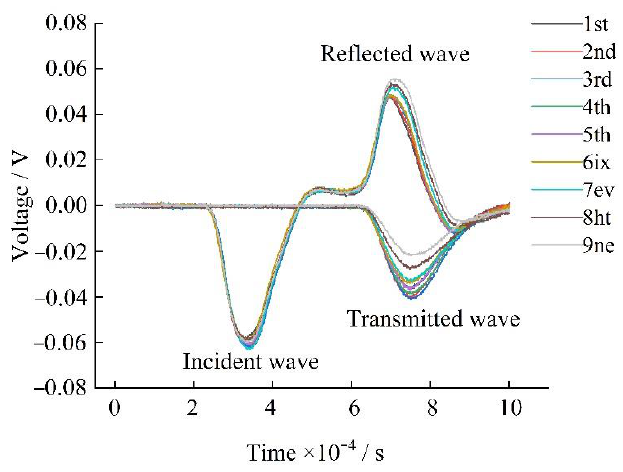
Figure 4. Typical stress waves during cyclic impact.